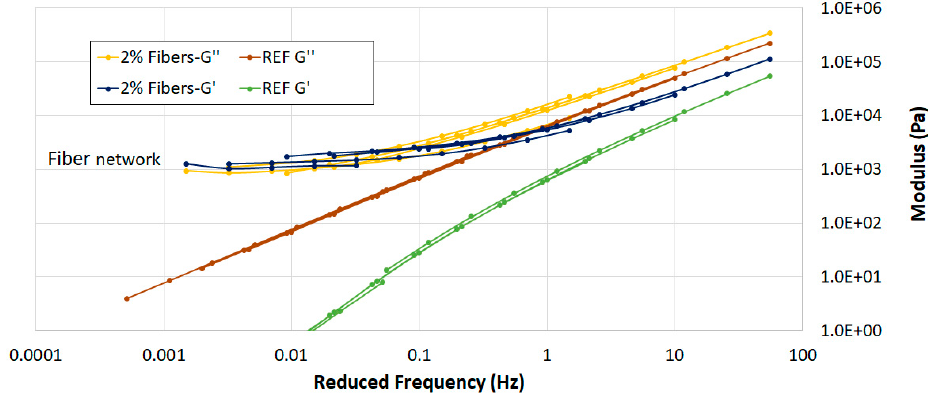
Figure 12. The master curves at 50 °C for the reference binder and the 2% fiber sample.